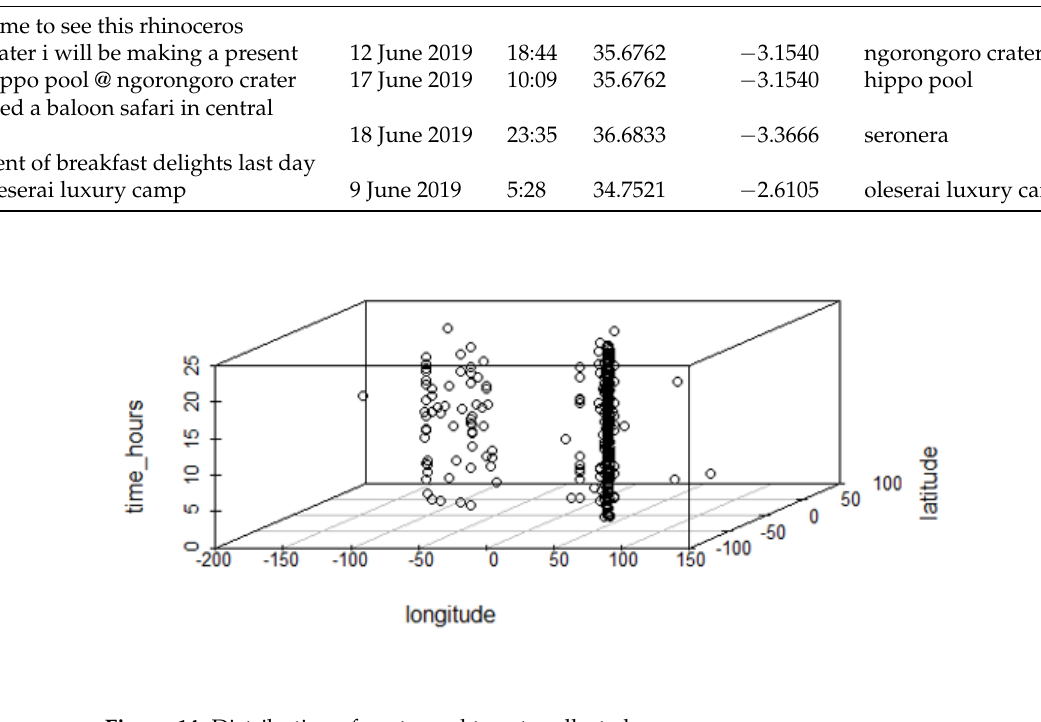
Figure 14. Distribution of geotagged tweets